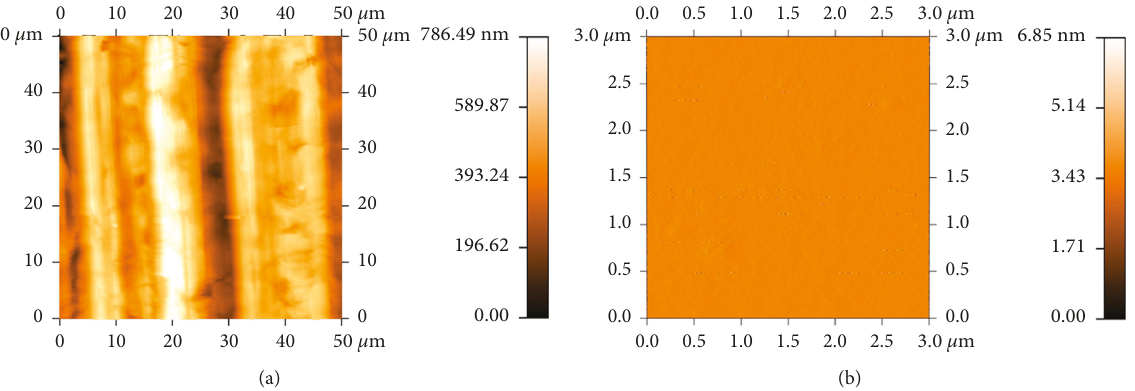
Figure 1: AFM topographical images of (a) as-received Cu foil and (b) polished Cu foil. Table 1: Sputtered conditions for deposition of Al 2 O 3 and Au films.